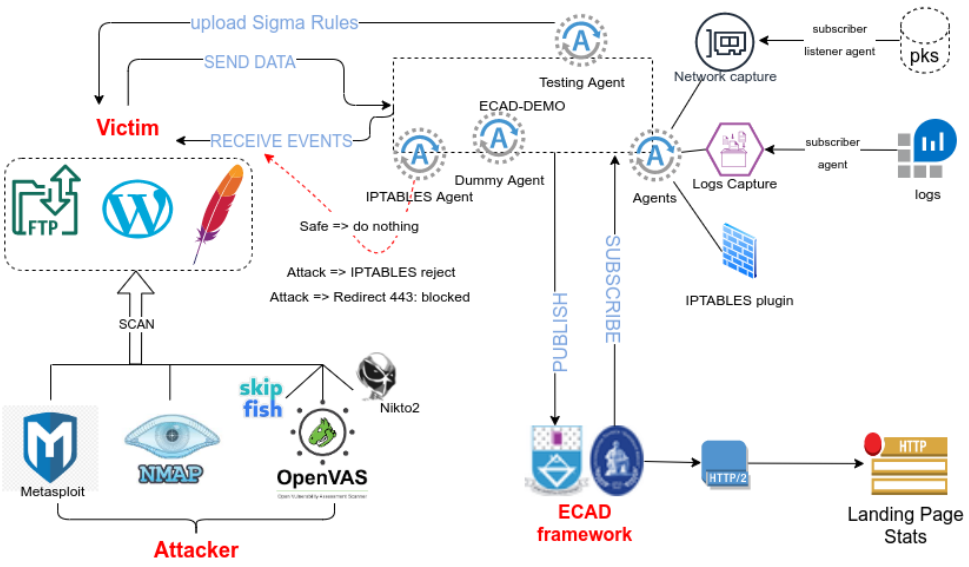
Figure 6. The testing platform for the ECAD